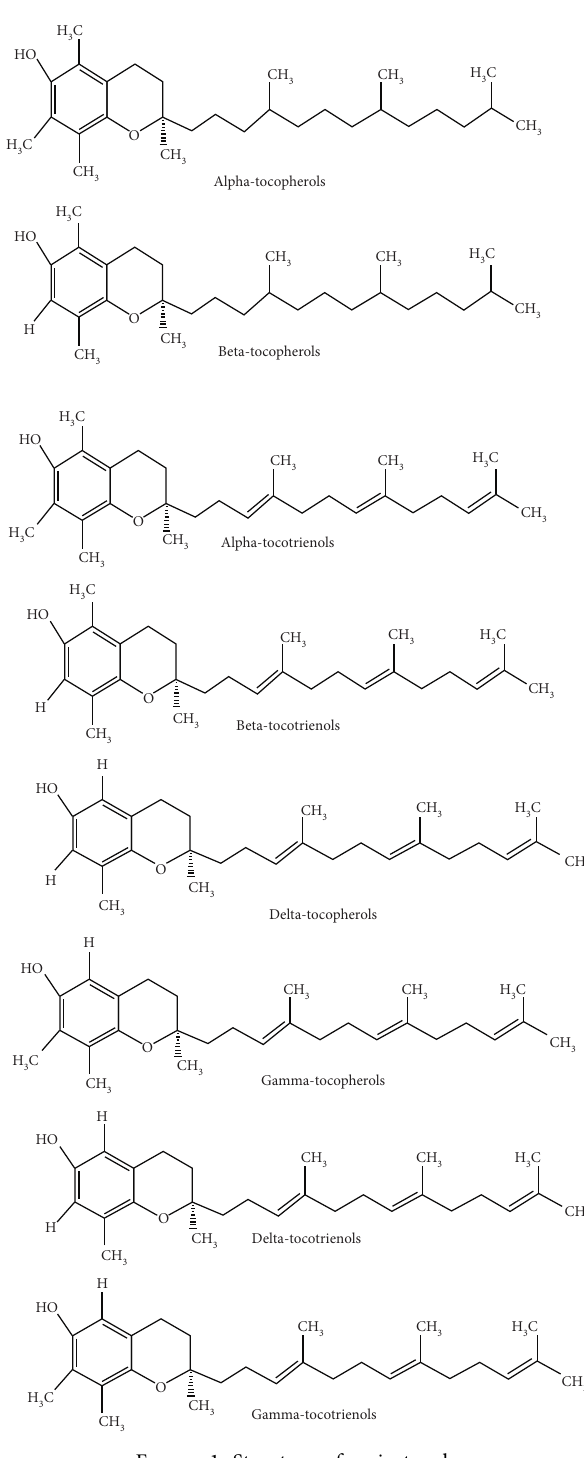
Figure 1: Structure of main